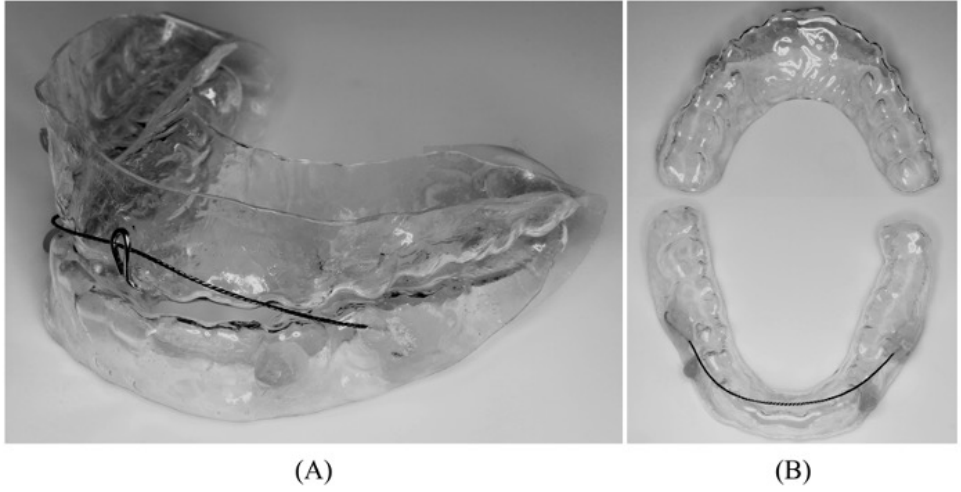
Figure 2. Design of the two-piece MAD used in this study. ( A ) lateral view and ( B ) upper and lower plates. MAD: mandibular advancement device.